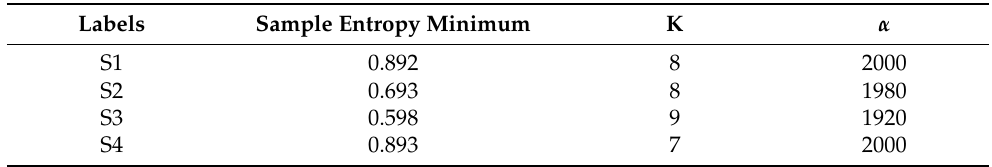
Table 3. The corresponding K and α of WOA − VMD under different fault states and minimum sample